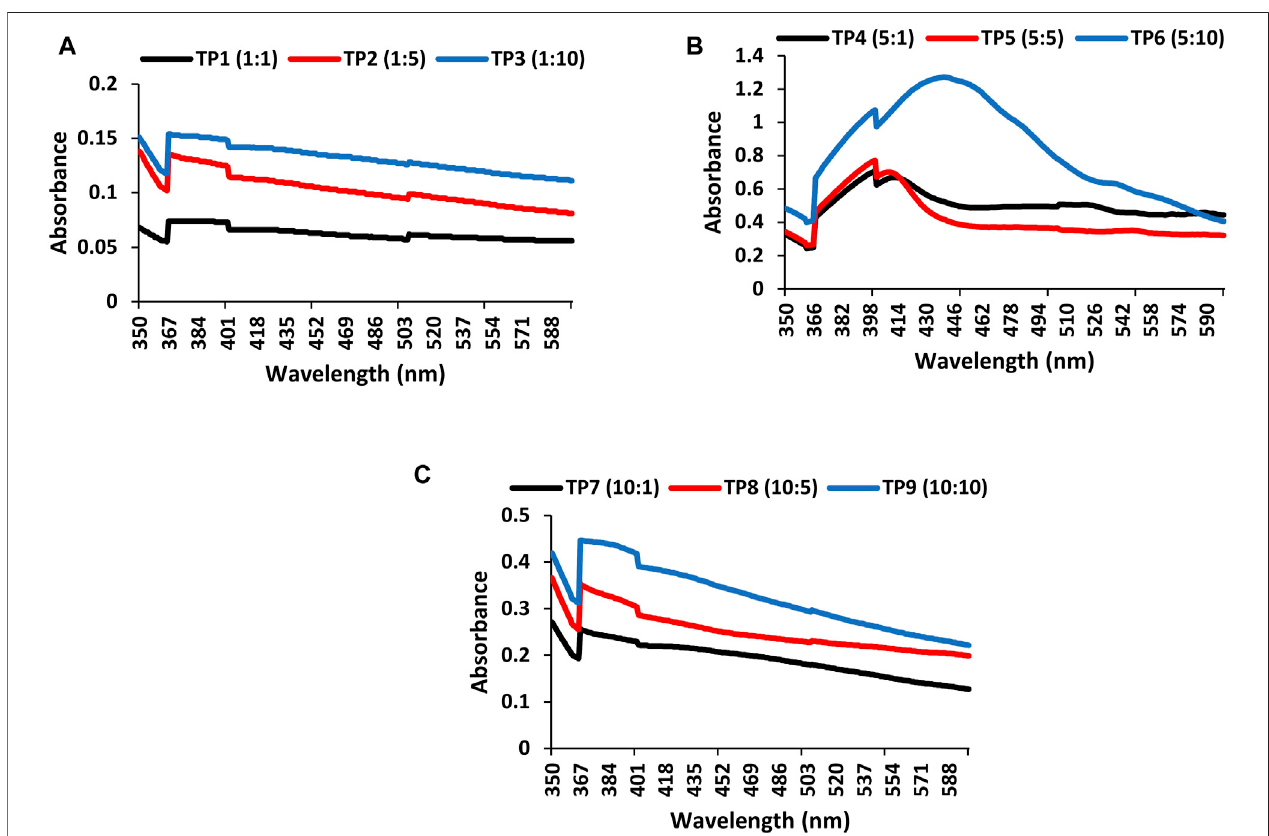
FIGURE 2 | UV – Vis spectra of TpAgNPs synthesized by different concentrations of AgNO 3 and plant extract: (A) Tradescantia pallida (TP) silver nanoparticles synthesized with 1 mM AgNO 3 and 1, 5, and 10 mg ml − 1 of plant extract (TP1, TP2, and TP3), (B) Tradescantia pallida (TP) silver nanoparticles synthesized with 5 mM AgNO 3 and1,5,and10 mg ml − 1 ofplantextract(TP3,TP4,andTP5), (C) T.pallida (TP)silvernanoparticlessynthesizedwith10 mMAgNO 3 and1,5,and10 mg ml − 1 of plant extract (TP7, TP8, and TP9).